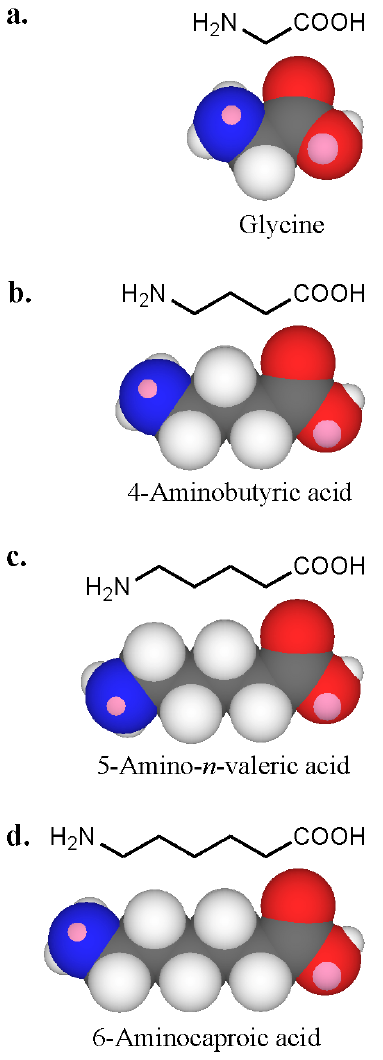
Figure 17. Three-dimensional CPK models of amino acids of increasing carbon chain length (a to d, glycine to 6-aminocaproic acid) showing the proximity of the carboxyl group to the amino group in each